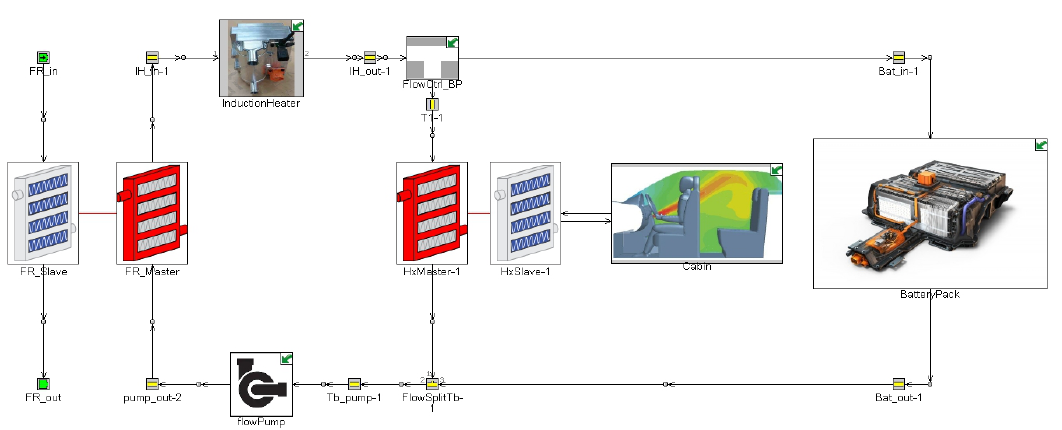
Figure 2. Schematic diagram of the battery thermal management system: parallel